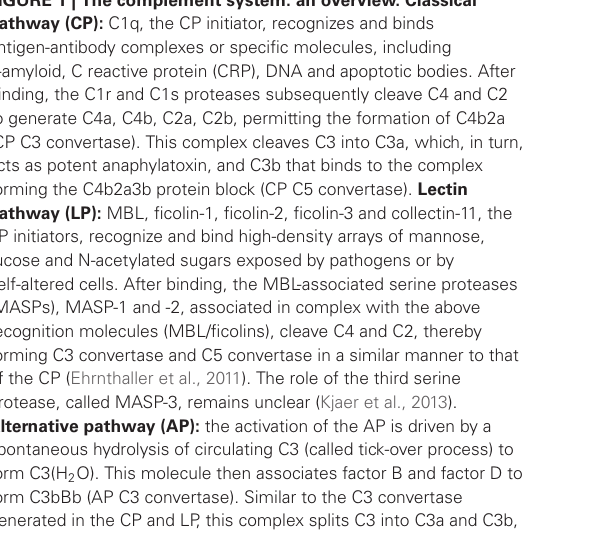
with the latter creating a new C3 convertase (AP amplification loop, dotted line), and/or binding C3 convertase already present to create the C3bBb3b complex (AP C5 convertase). Extrinsic pathway: the recent characterization of this activation pathway suggests that it